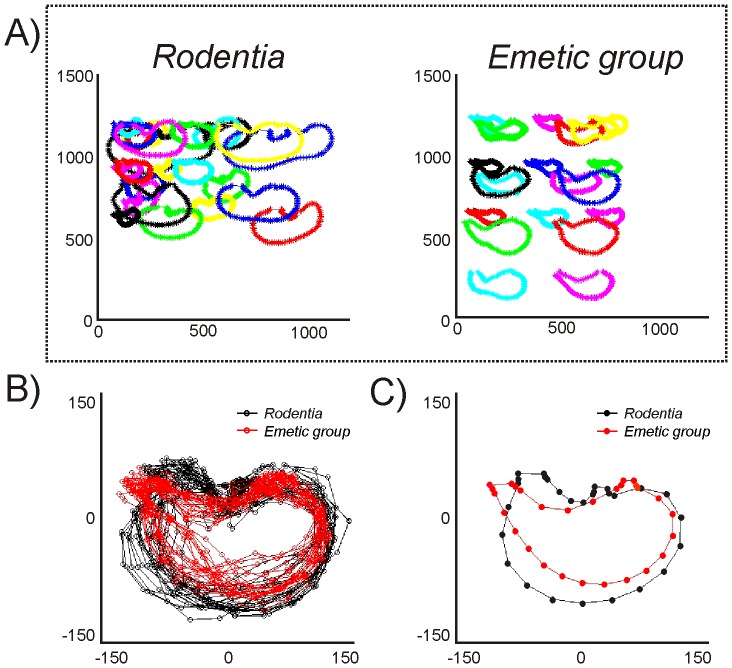
Stomach shape analysis.
A) Initial X and Y coordinates of ventral stomach shapes for the Rodentia group (n = 32) and emetic group (n = 25). B) All stomach shapes were aligned using a Procrustes analysis (including translation, rotation, and scaling). C) Average group values for the Procrustes transformed stomach shapes: Rodentia (in black) and emetic group (in red). Hotelling T2 statistic = 0.59, p<0.001, Rodentia compared to emetic group. X and Y coordinates in each figure represent arbitrary units in image graphics.